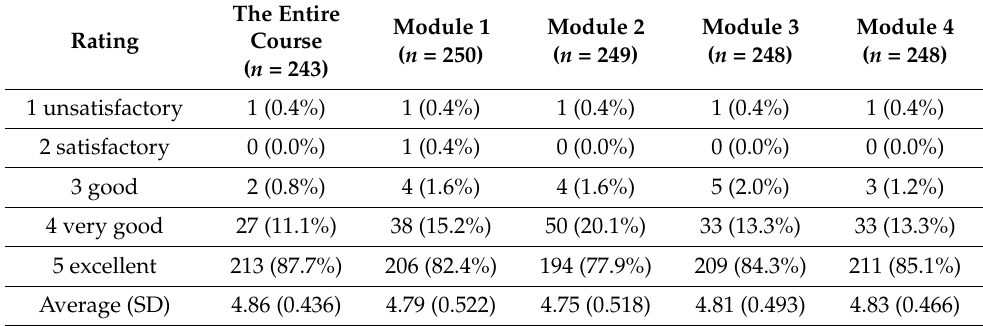
Table 2. Participant ratings for the course and individual modules.